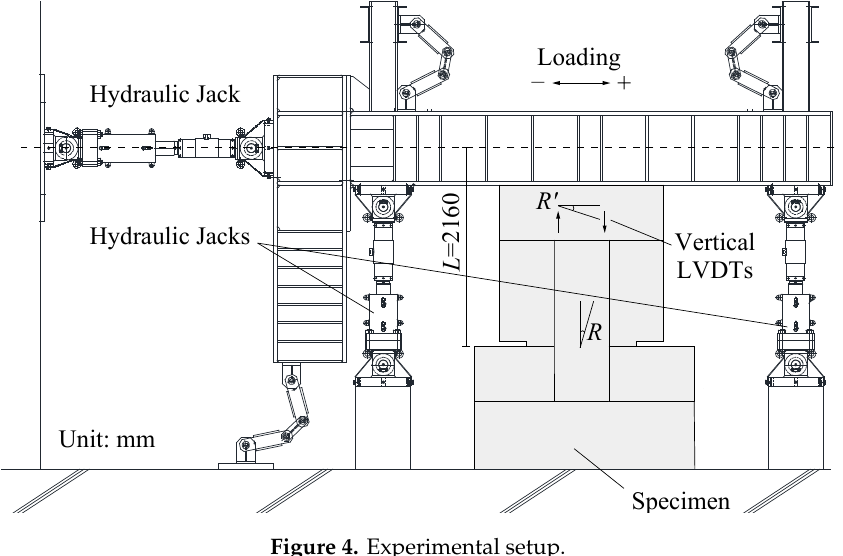
Figure 4. Experimental setup.